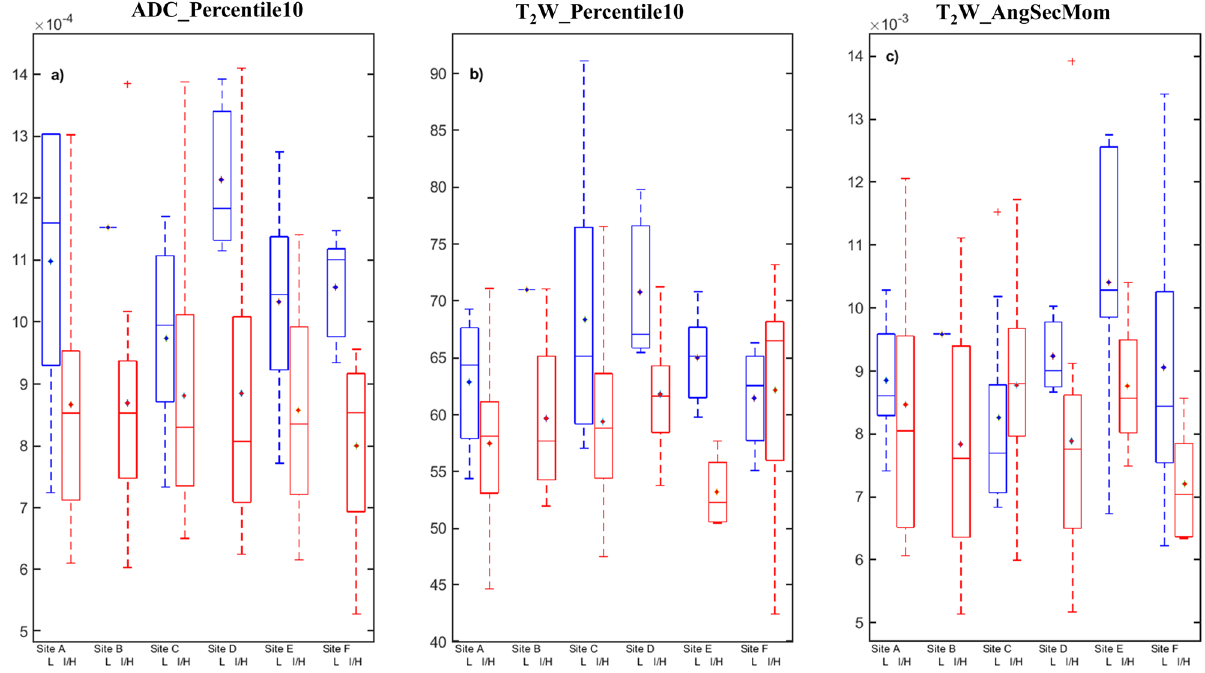
Figure 4. Box plots showing the distributions of apparent diffusion coefficient (ADC) and T 2 -weighted (T 2 W) histogram (10 th percentile), and T 2 W textural (angular second moment) features between low-aggressive (L) and intermediate/high-aggressive (I/H) prostate cancers at the participating institutions or sites. Notice that, where the T 2 W histogram feature (middle; Site F) overlap between the two cancer groups, an improved separation is observed for the textural feature (right; Site F), and vice-versa, indicating that the feature sets contain complementary information. *Indicates mean